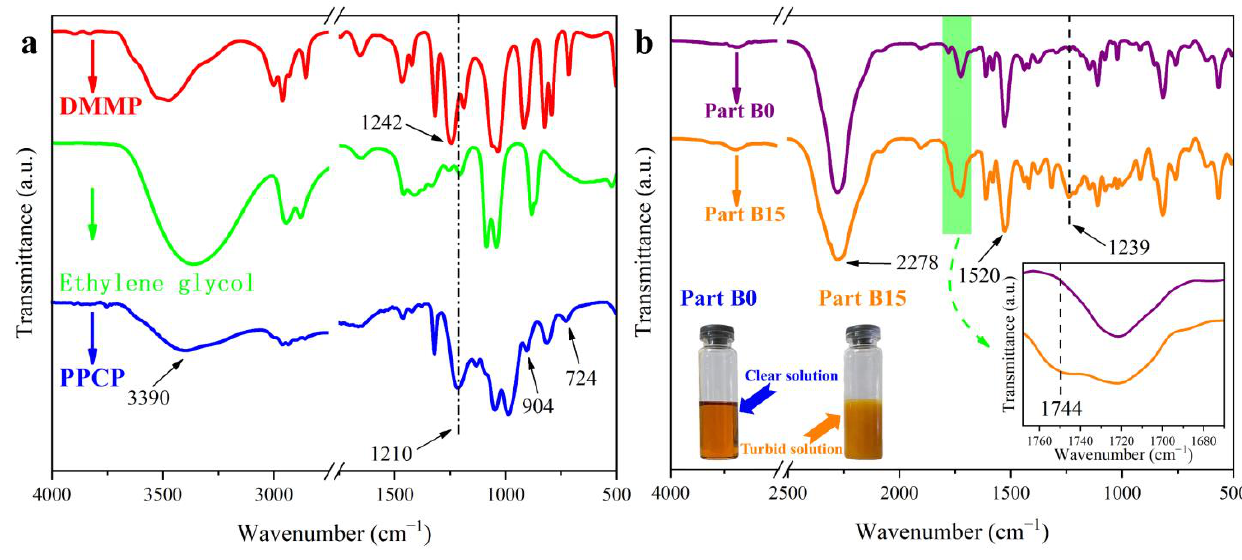
Figure 1. ( a ) FT-IR curves of DMMP, ethylene glycol, and PPCP. ( b ) Digital photos and FT-IR curves of Part B0 and Part B15.